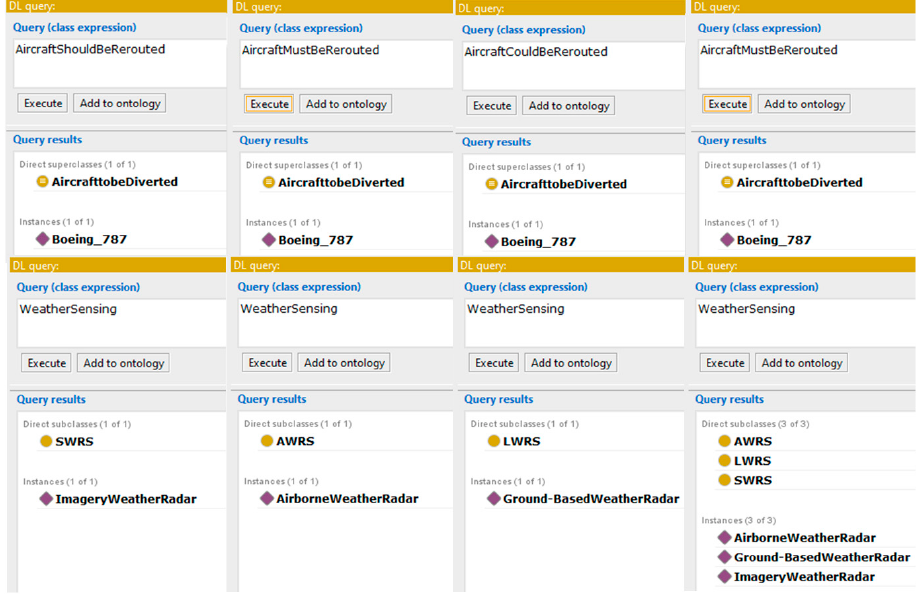
Figure 14. Querying results to assess airspace situation in Scenario 1.